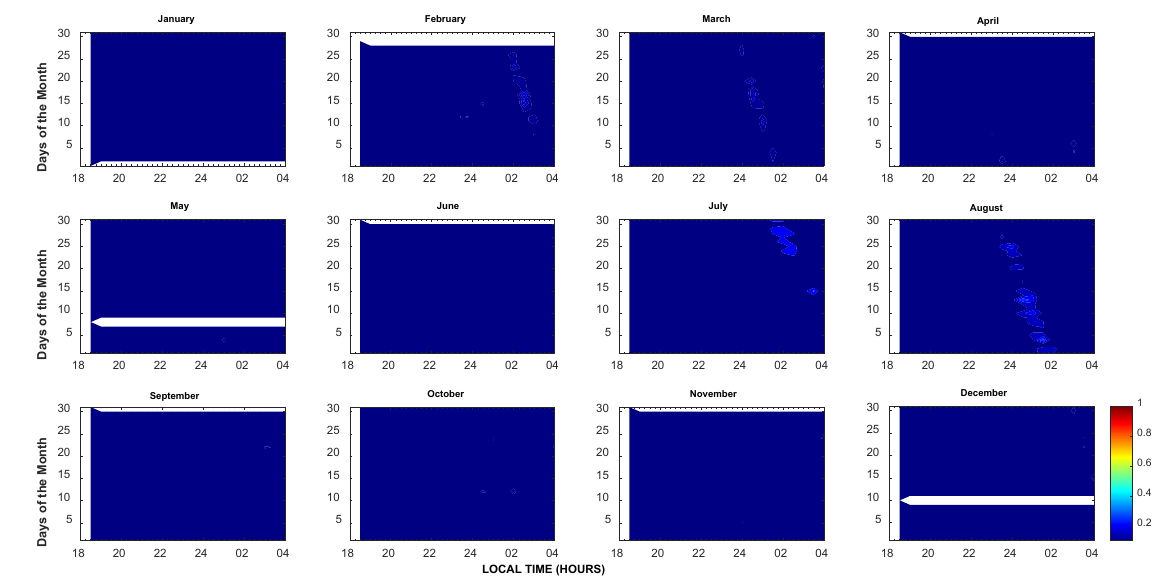
Figure 7. Monthly ROTI variation over the BJCO receiver during a low-solar-activity period (2010).